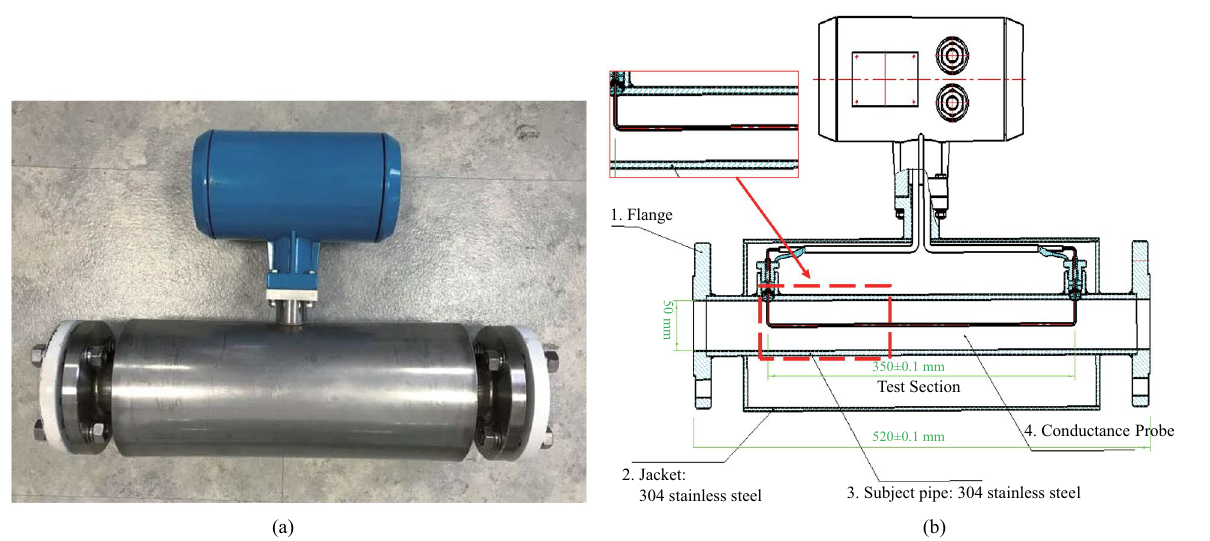
Figure 2. ( a ) Photograph of the water holdup instrument designed for the experiments. ( b ) The internal structure of the water holdup instrument 3